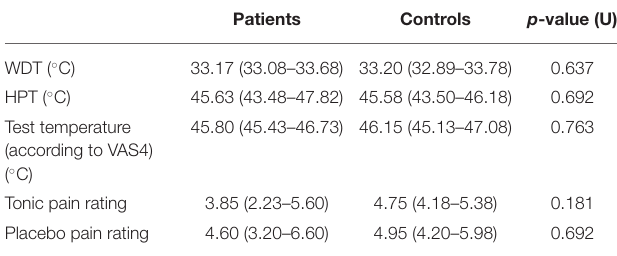
TABLE 2 | Results of psychological questionnaires in patients and controls at T1 TABLE 3 | Warmth detection and heat pain thresholds and pain perception in [reported as median (1st quartile − 3rd quartile)]. patients and controls at T1 [reported as median (1st quartile − 3rd quartile)]. Patients Controls p -value (U) Patients